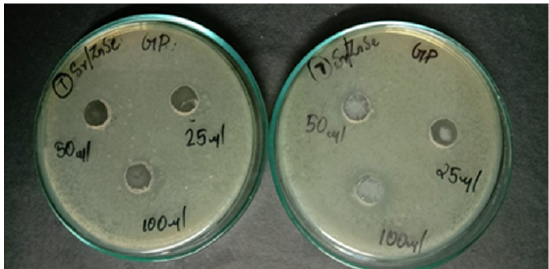
Figure 7- XPS spectra of Sr (0.1)-doped ZnSe nanoparticles; ( a ) wide spectrum, ( b ) Sr-3d spectrum, ( c ) Zn-2p spectrum, ( d ) Se-3d spectrum, and ( e ) C-1s spectrum.